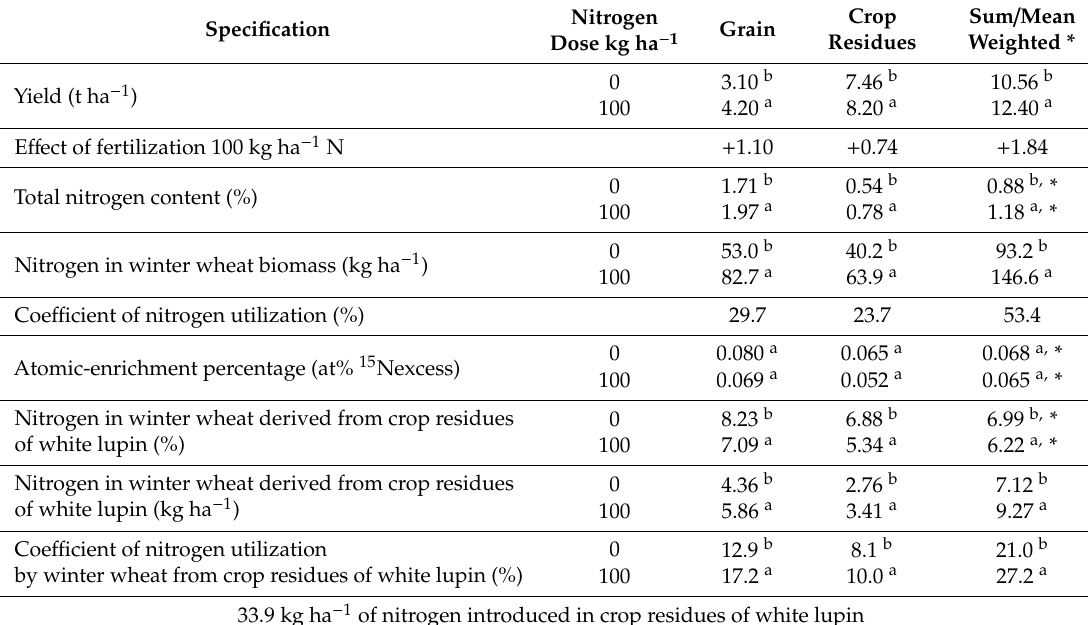
Table 5. Parameters of winter wheat harvested in